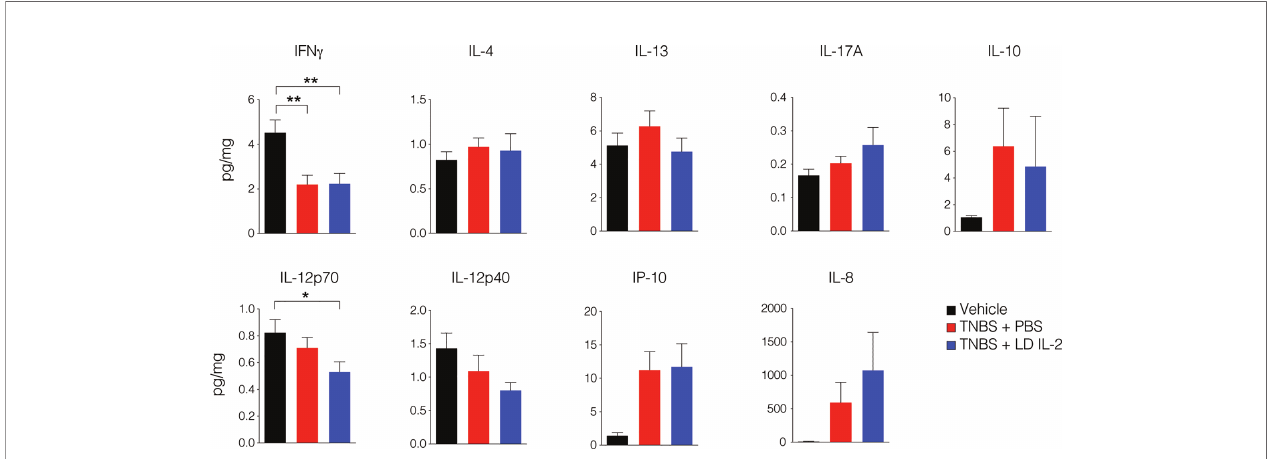
FIGURE 4 | Interleukin-2 (IL-12) production is reduced in mice treated with low-dose (LD) interleukin-2 (IL-2). Concentration of human cytokines in colon tissue of NOD. Prkdc scid Il2rg -/- (NSG) human immune system (HIS) mice 3 days post-rectal challenge with trinitrobenzensulfonic acid (TNBS) or vehicle as a control determined by Luminex ( n ≥ 11 per group). Histograms are the mean concentration pooled from three independent experiments ± SEM. * P < 0.05, ** P <